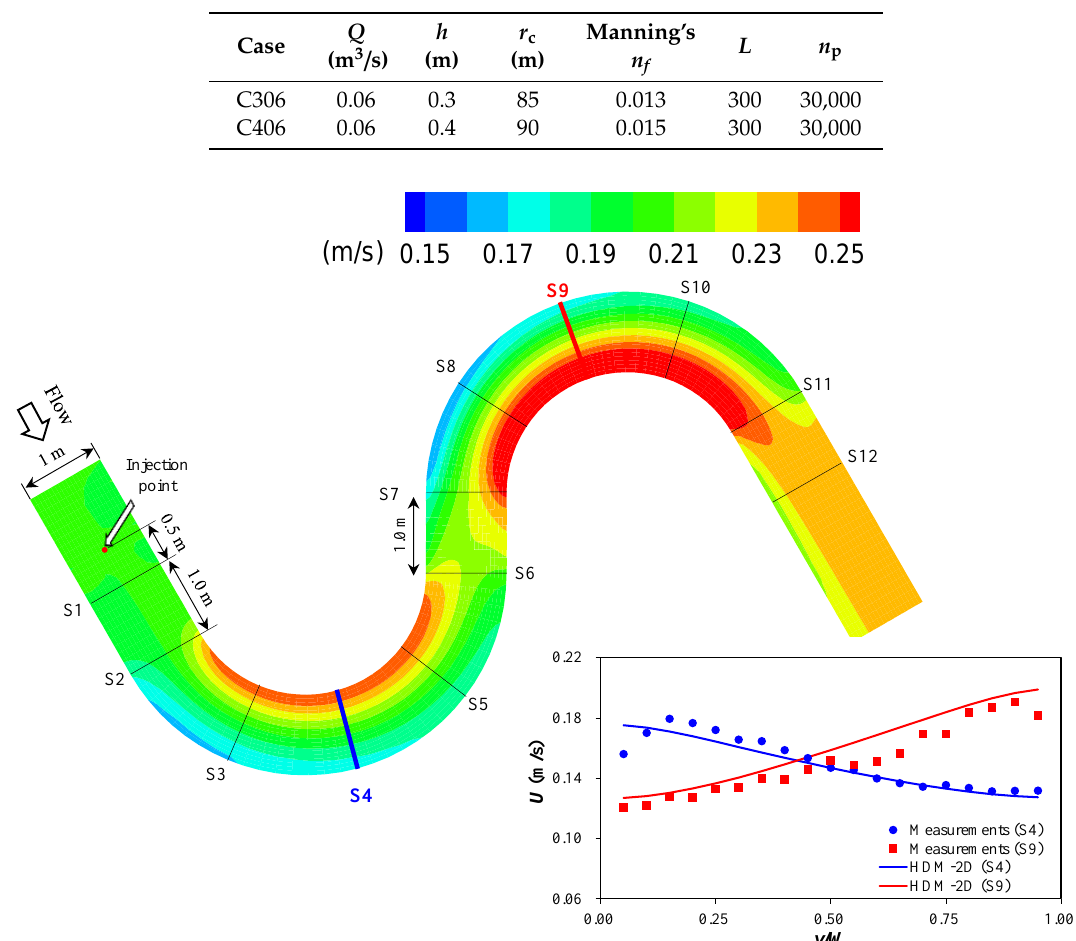
Figure 6. Descriptions of the meandering channel and the velocity magnitude resulting from the HDM-2D (C306).